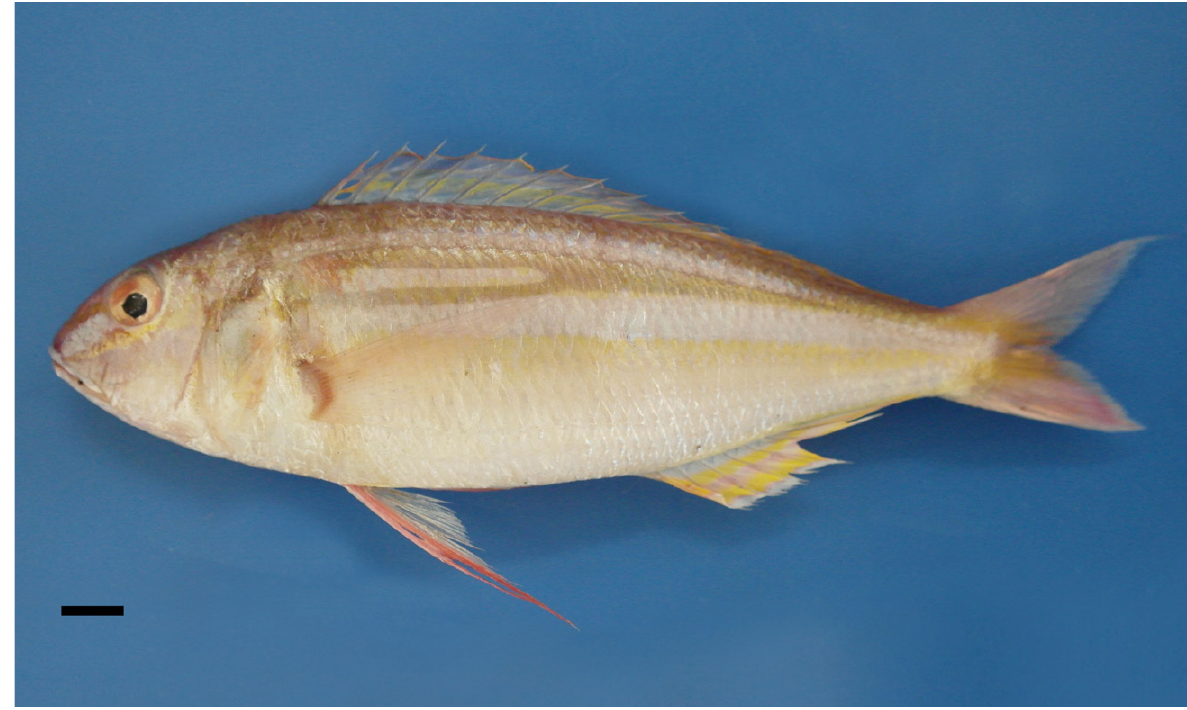
Figure 2. Nemipterus marginatus from the coast of North Central Vietnam (LB.005). Scale bar = 1 cm.